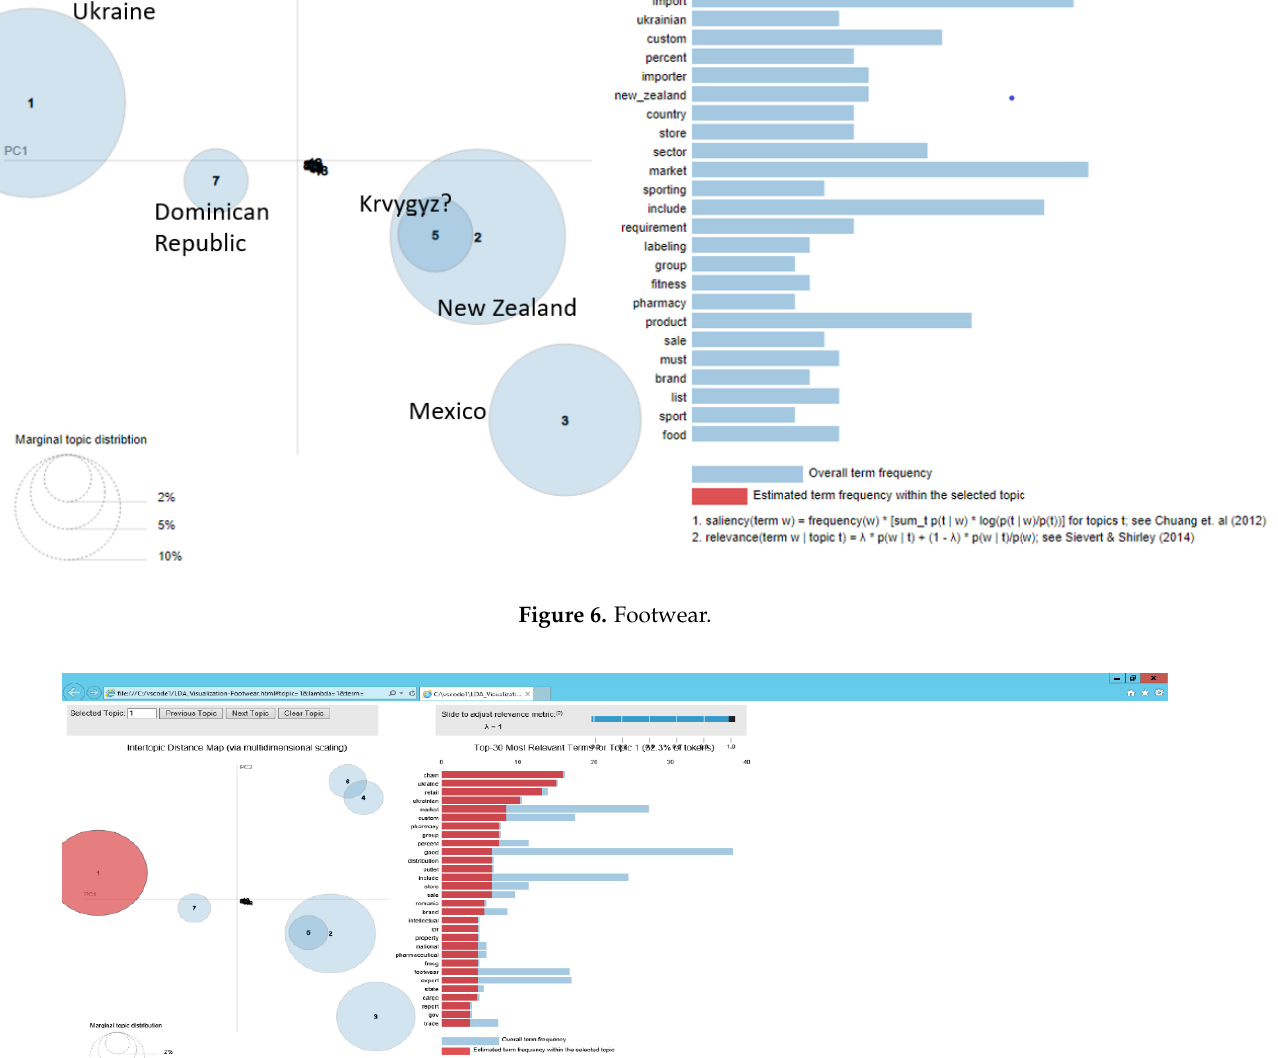
Figure 7. Footwear: Topic 1. This image shows the LDAVis screen with Topic 1 selected .